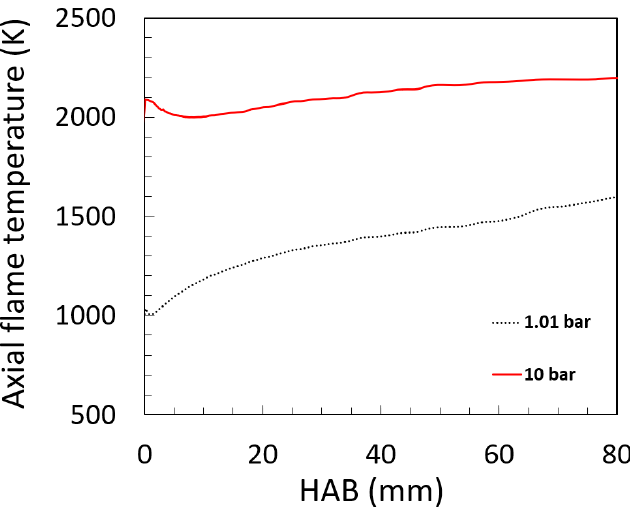
Figure 4. Centerline flame temperature (K) in function of HAB (mm) of premixed flame C 2 H 4 /air ϕ = 1.77 at atmospheric pressure (dotted line) and 10 bar (solid line). p = 1.01 bar